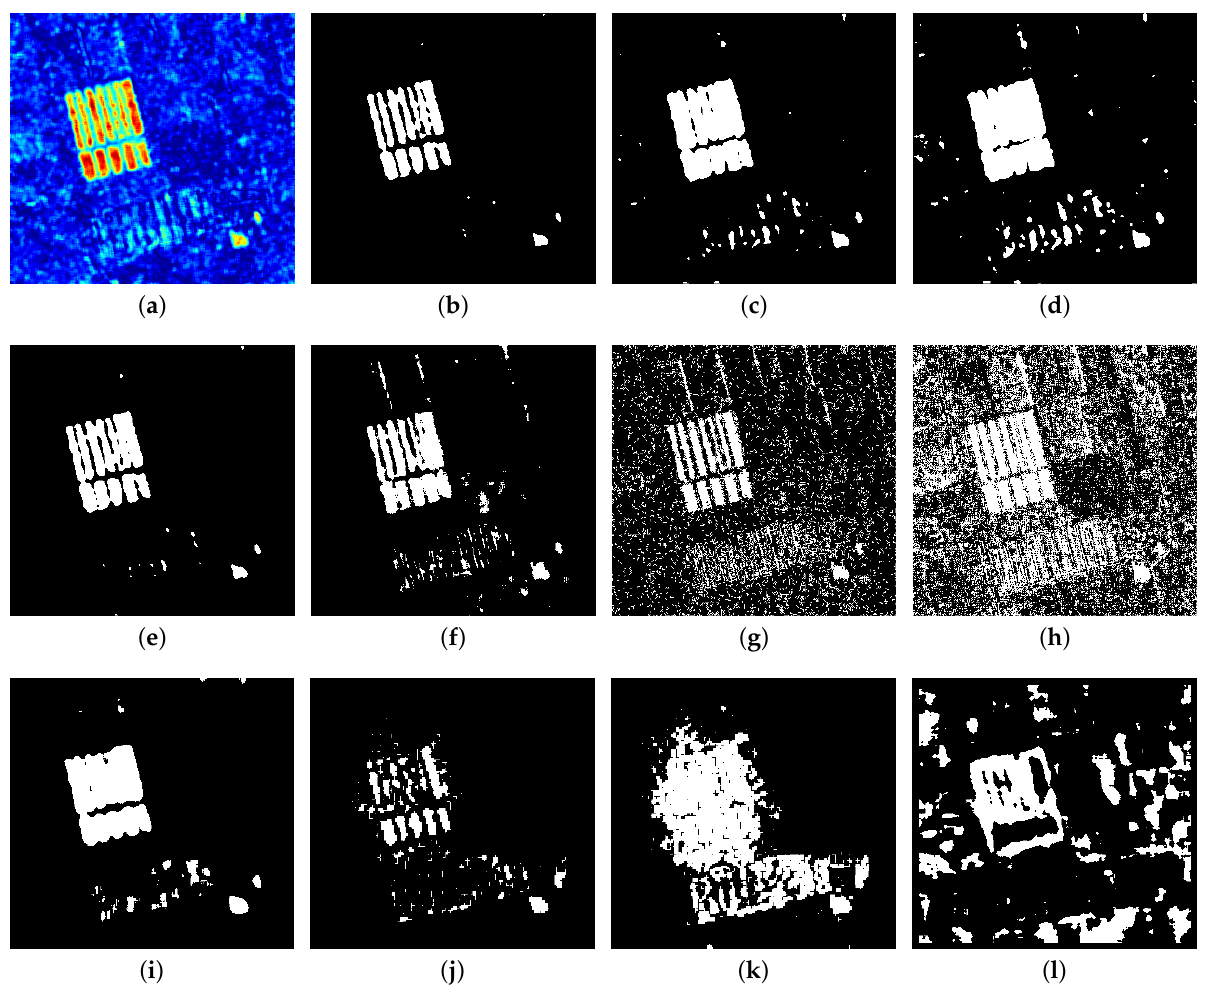
Figure 6. Change maps of the different methods on Dataset #2. ( a ) DI of proposed method (heat map). ( b ) SNLSW-TAE (ours). ( c ) SNLSW-Otsu (ours). ( d ) SNLSW-K&I (ours). ( e ) SNLSW-CFAR (ours). ( f ) HHG. ( g ) MRFFCM. ( h ) LR-FLICM. ( i ) LR-PCAKmeans. ( j ) NLPG-Otsu. ( k ) NLPG-CFAR. ( l )